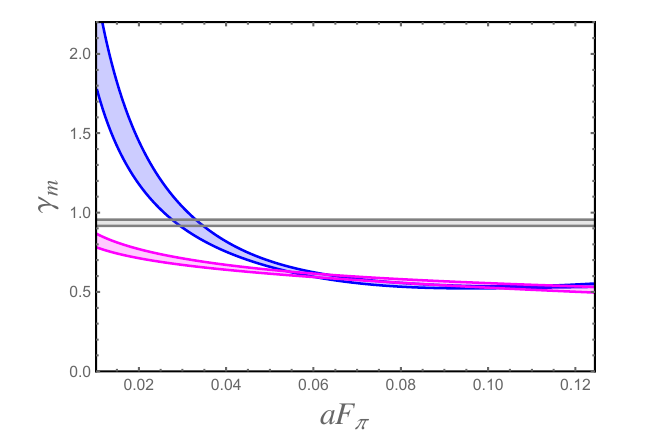
Figure 3. The running mass anomalous dimension γ ( m ) , obtained from various fits of the LatKMI data, as a function of aF ⇡ ( m ) , see text. Taken from Ref. Figure 2. M 2 ⇡ / F 2 ⇡ , aF ⇡ and M 2 ⌧ / F 2 ⇡ as a function of the bare fermion mass in lattice units, am. Taken from Ref. [11].